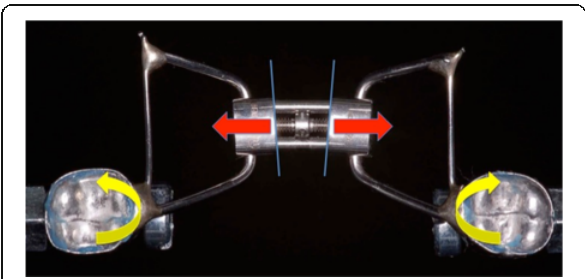
Fig. 13 Four-arm RPEs: bending moment generated on the vertical plane